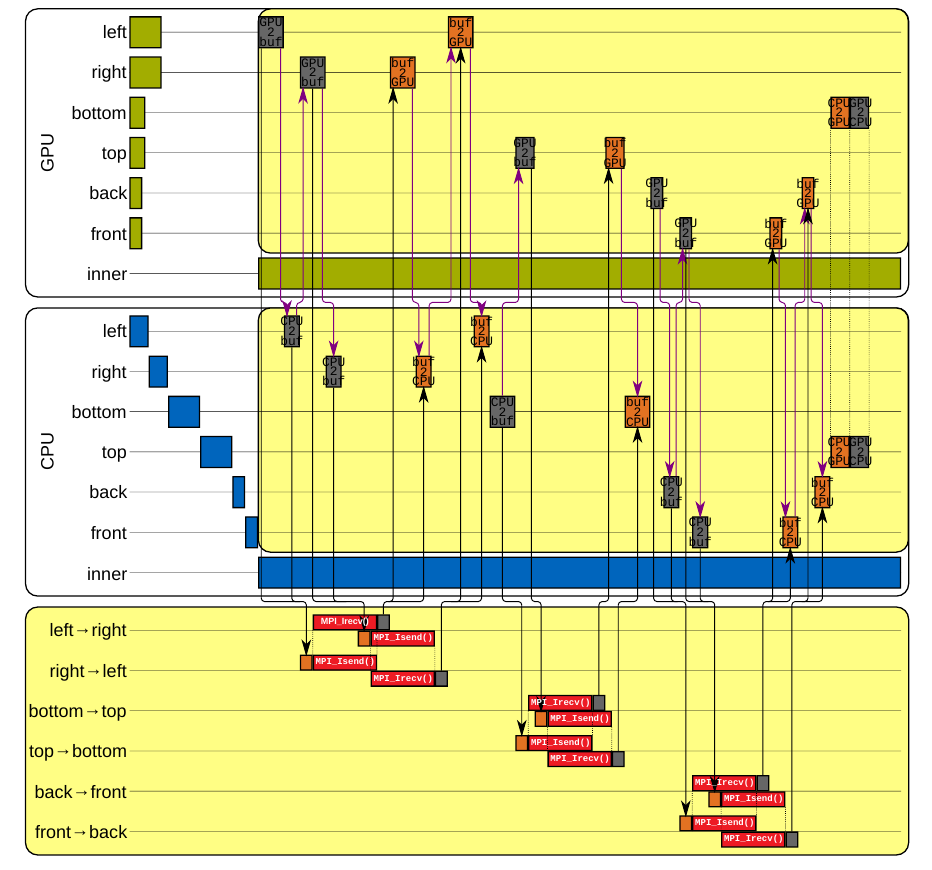
Figure 7. Timeline of one MPI process during an α - or β -step [19]. Operations are grouped in GPU ( top ), CPU ( middle ), and MPI ( bottom ) activities. Within each computing device’s group, operations affecting the six faces and the inner cells are illustrated. Communication and copy actions are highlighted by yellow background, computations by white background. Green and blue bars indicate computations on the GPU and CPU. Red bars symbolize MPI communication distinguished between sending ( MPI_Isend() ) and receiving ( MPI_Irecv() ). Communication directions are denoted by “from ...neighbor → ...boundary layer”. Grey and orange bars represent memory transfers to and from the communication buffers stored on the host, respectively. Bars marked with “GPU2buf” perform a copy operation from the GPU to the communication buffers and those with “CPU2buf” from the CPU to the communication buffers. The copy operations from the communication buffers to the computing devices are marked with “buf2GPU” and “buf2CPU”. Copy operations along the interface between CPU- and GPU-part of the subdomain are called “CPU2GPU” and “GPU2CPU”. Black arrows indicate data dependencies, purple arrows illustrate dependencies due to shared